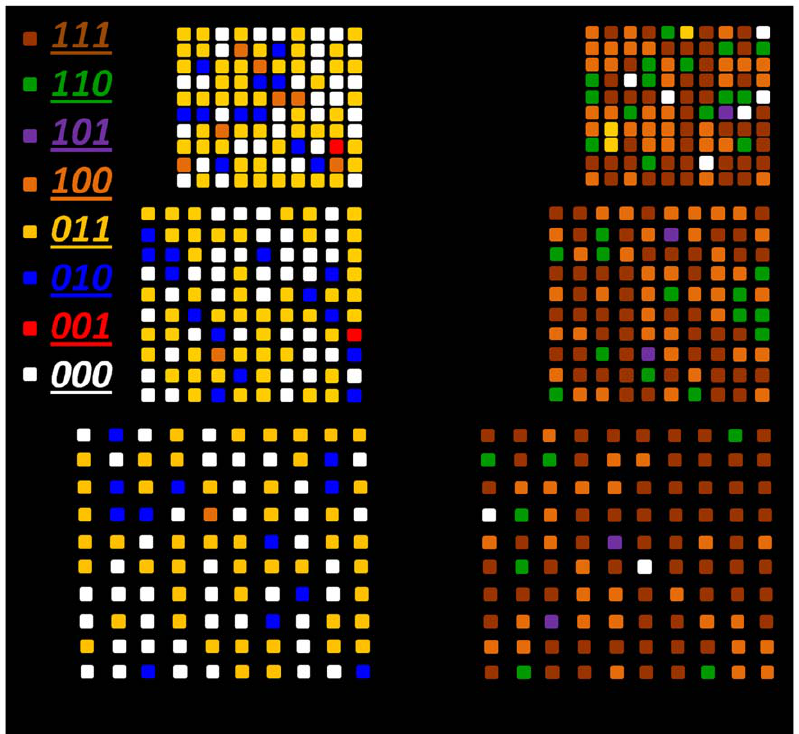
Figure 9. Diagram of MFM data. A schematic highlighting the various magnetic states of the nanopillars shown in Figure 7.